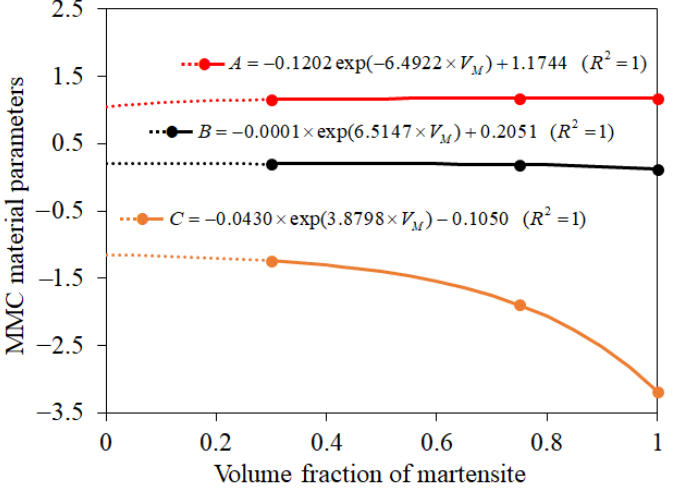
Figure 19. Variations in the MMC material parameters with the martensite content (%v) in various die-quenched microstructures of Ductibor ® 1000-AS. The solid lines represent the interpolated data, and the dotted lines denote the extrapolated data. The symbols display the data points for the reference